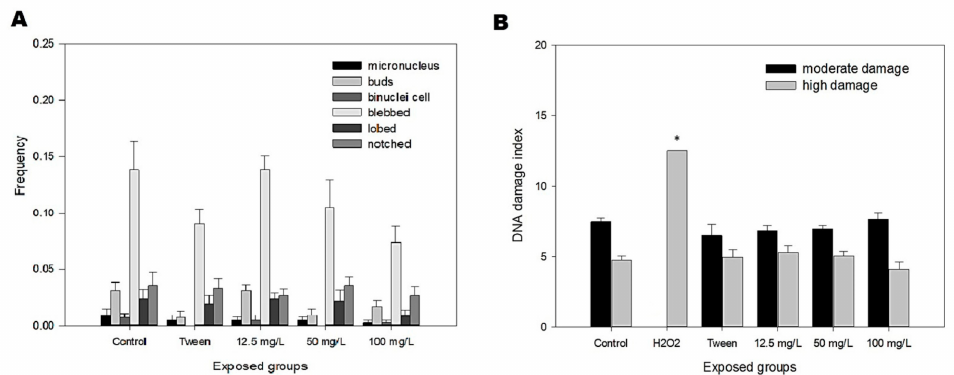
Figure 6. ( A ) Frequencies of micronucleus and nuclear abnormalities in peripheral erythrocytes of zebrafish adults. The result shows no statistical significance ( p > 0.05). ( B ) Result of the comet assay. Moderate damage means tail length 1, 2 and high. H 2 O 2 was highly positive (* p < 0.05).